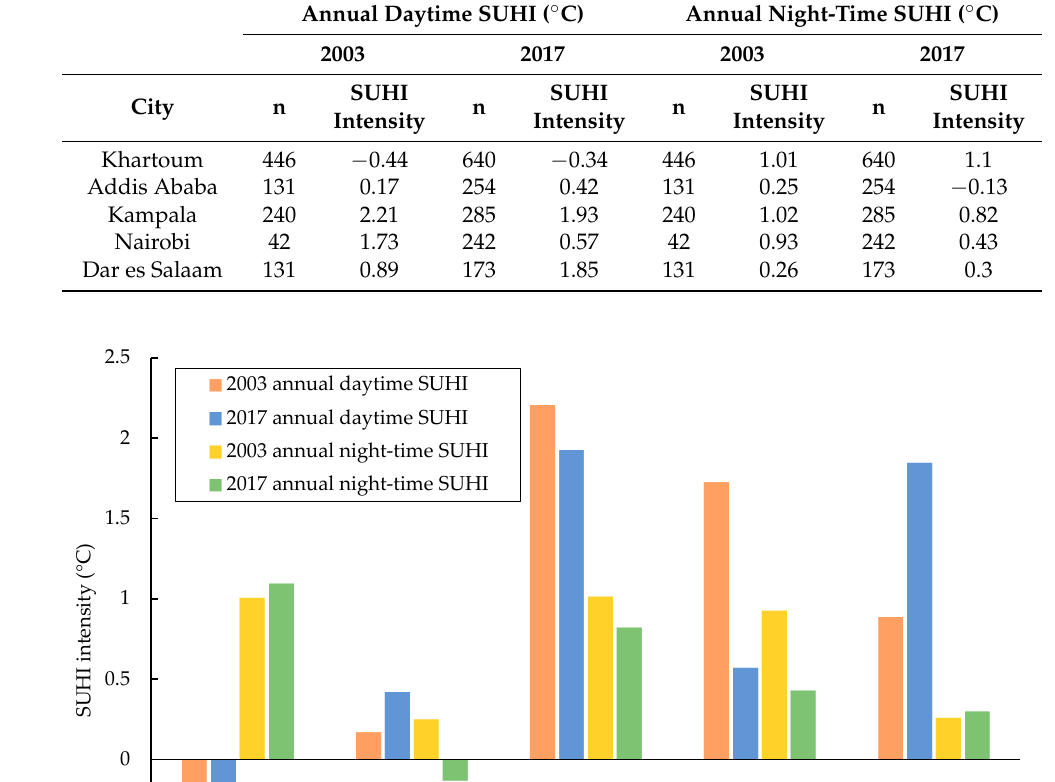
Table 3. SUHI intensity during daytime and night-time in the study cities in 2003 and 2017. The n value is the number of UHI pixels.